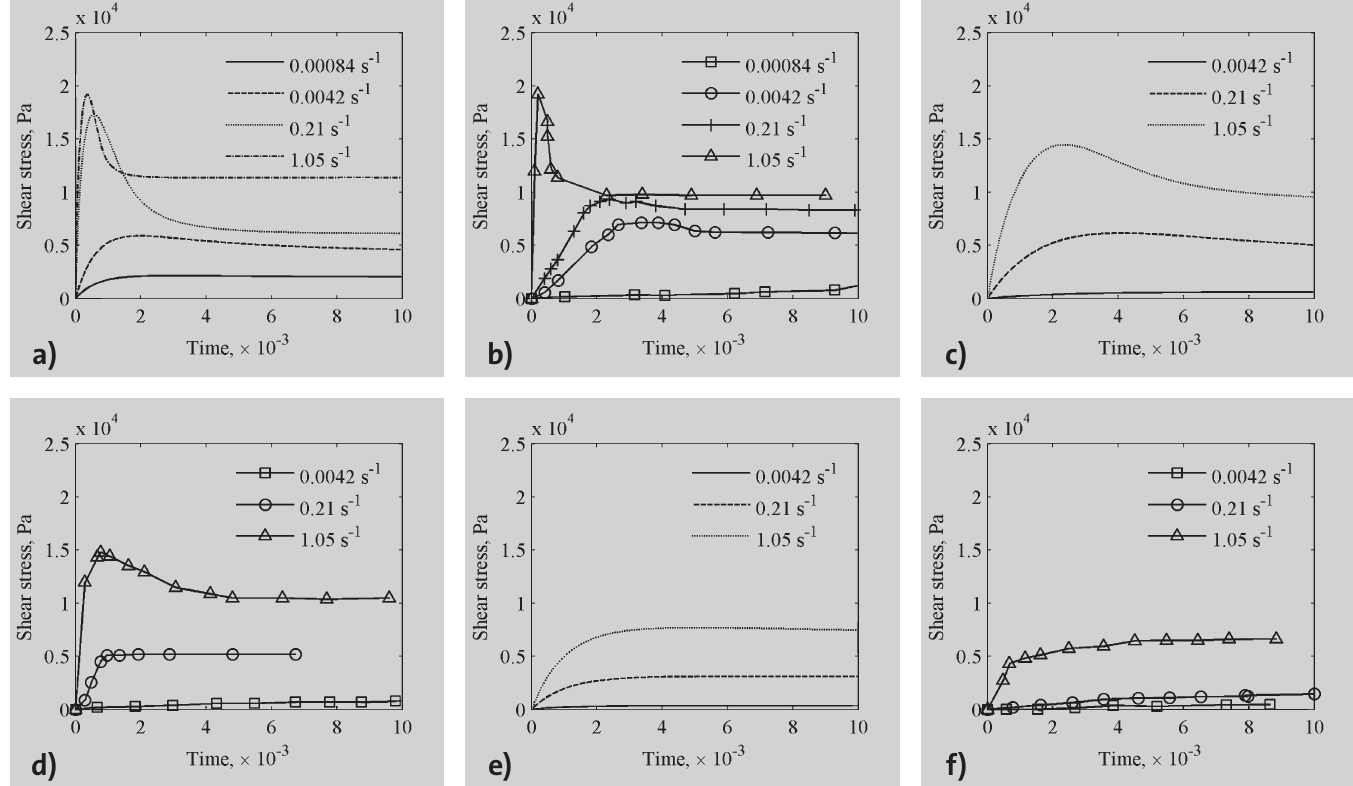
Figure 5: Comparison of the time dependence of the shear stress for different shear rates: (a) Asphalt 1, model results, (b) Asphalt 1, experimental data trends